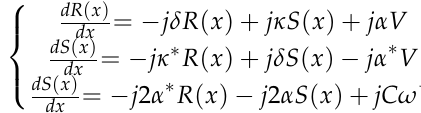
Figure 2. IDT structure model of the phonon piezoelectric device of the NV center.